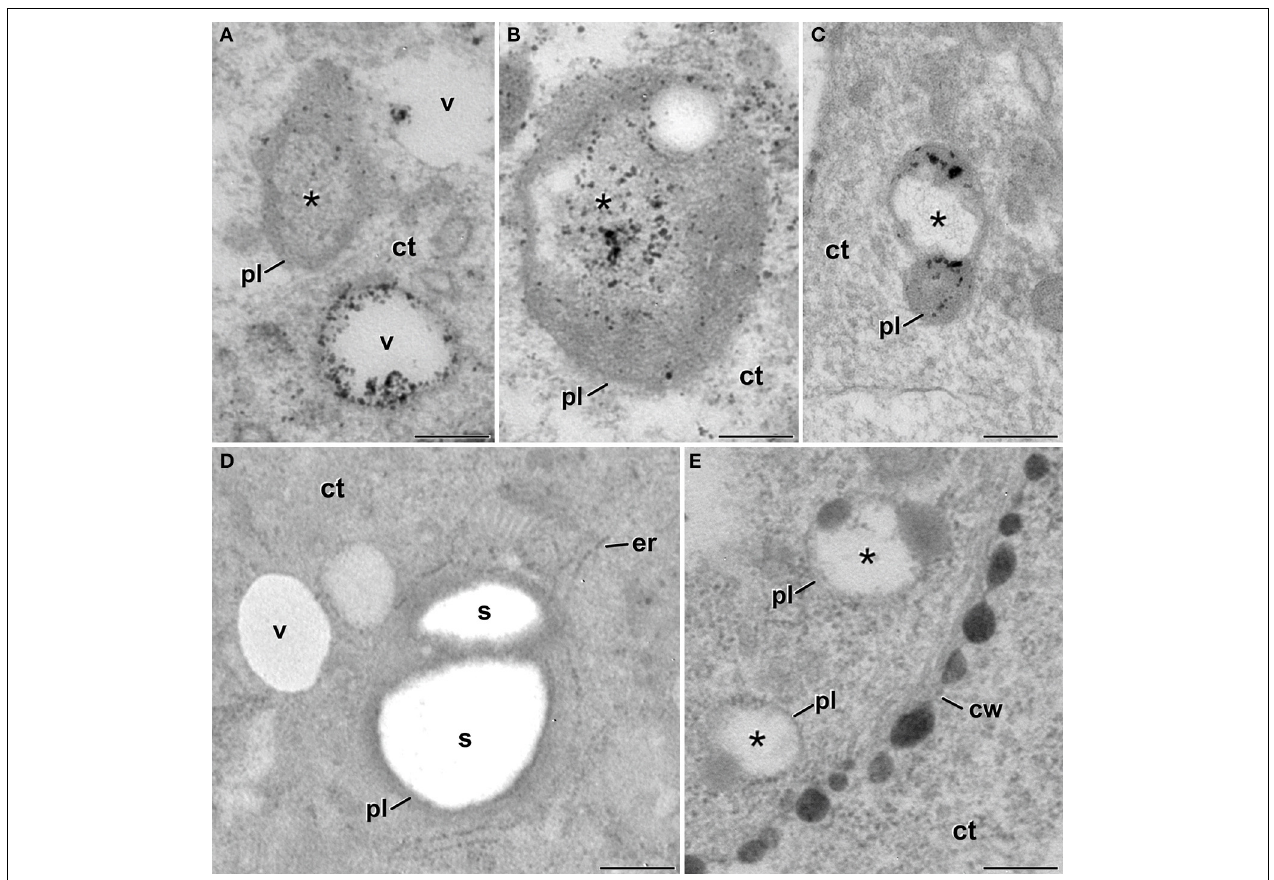
FIGURE 6 | Detection of acid phosphatase activity in cytoplasm-containing plastids of B. napus embryogenic microspores. (A) Cytoplasm-containing plastid (pl) showing a discrete acid phosphatase activity as revealed by the small and scarce dense precipitates. The cytoplasm compartment (asterisk) is devoid of precipitates. As a reference, two adjacent vacuoles (v) show different amounts of precipitates. (B) Cytoplasm-containing plastid where most of the dense precipitates